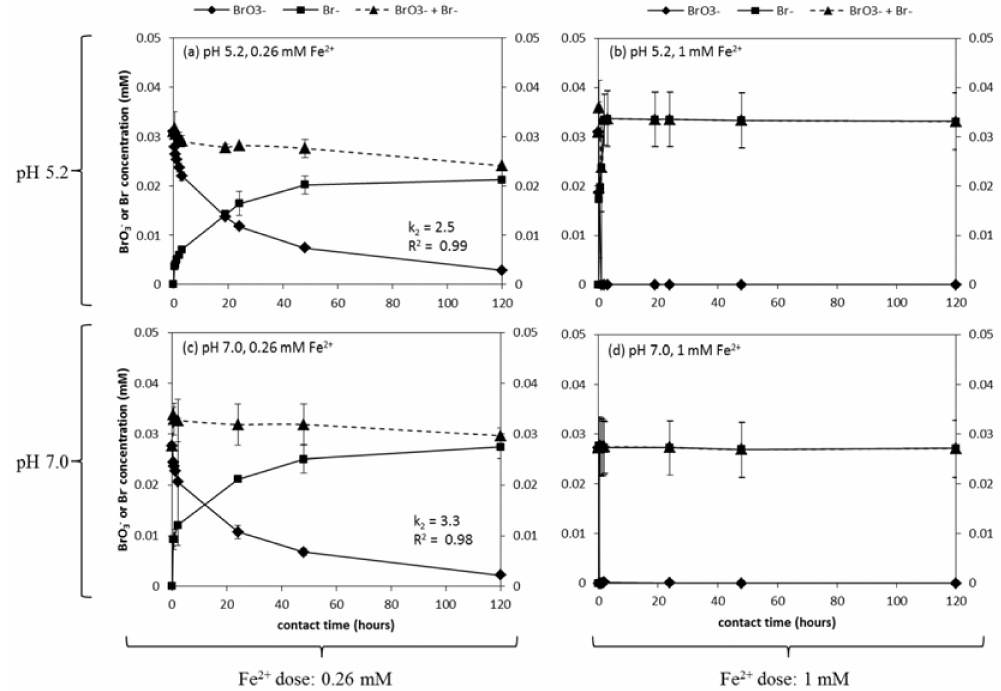
Figure 3. BrO 3 − reduction after dosing with ( a,c ) 0.26 mM or ( b,d ) 1 mM Fe 2+ . Initial BrO 3 − concentration was 0.03 mM and initial pH levels were 5.2 and 7.0. The calculated BrO 3 − reduction rates were 0.00024 µ M/min and 0.00026 µ M/min for a and c.